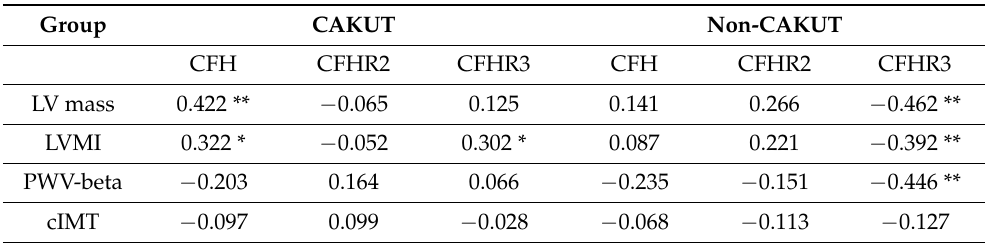
Table 3. Coefficient of correlation of CFH, CFHR2, CFHR3 vs. CV assessments in the CAKUT and non-CAKUT groups. non-CAKUT groups.